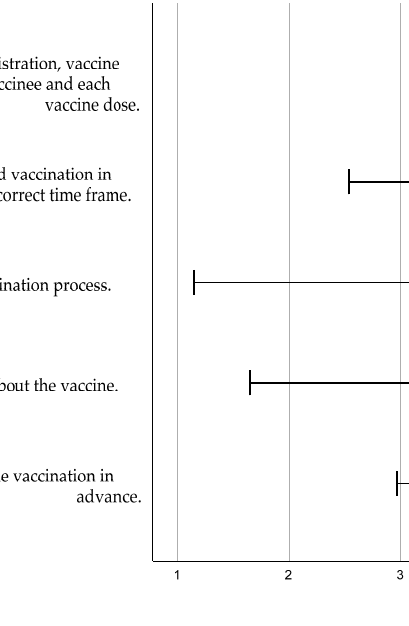
Mean values, standard deviation of the answers on the five-point Likert scale and Cronbach’s Alpha.